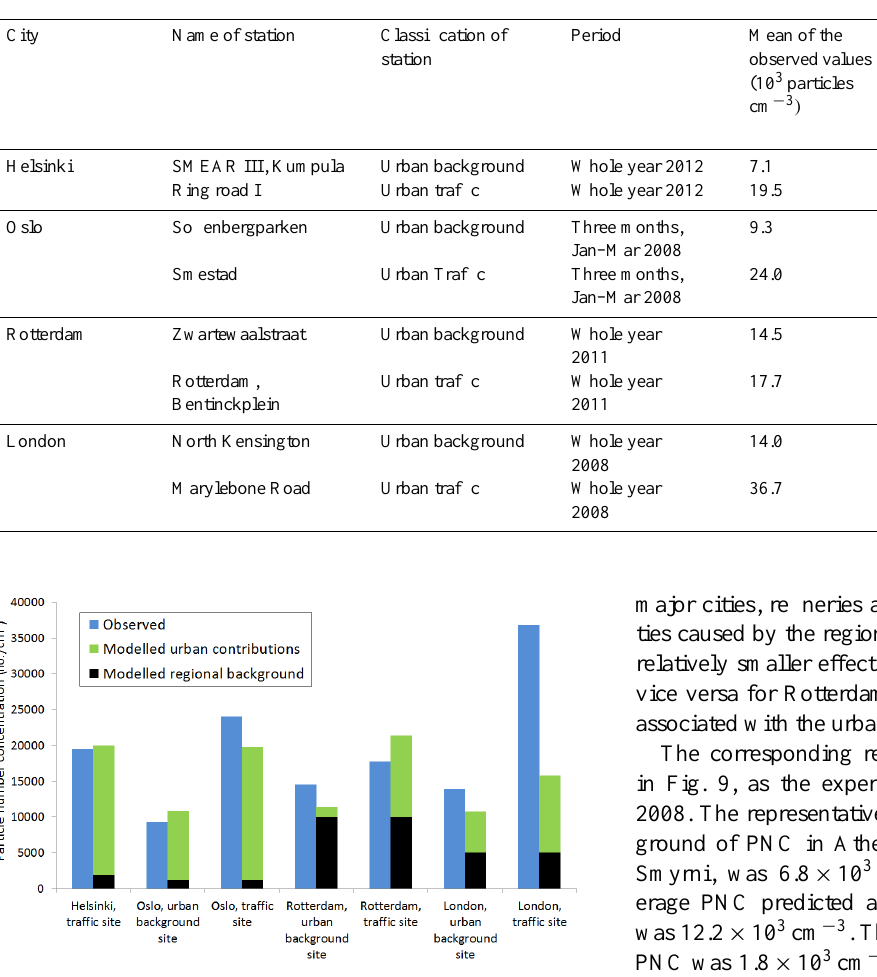
Table 3. The comparison of measured and predicted PNCs in four target cities. IA is the index of agreement and FB is the fractional bias. NA refers to data or evaluation measures that were not available.